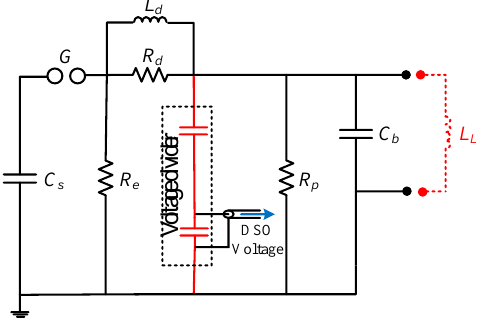
Figure 13. Equivalent circuit of the completed test system for the lightning impulse test of the reactor.